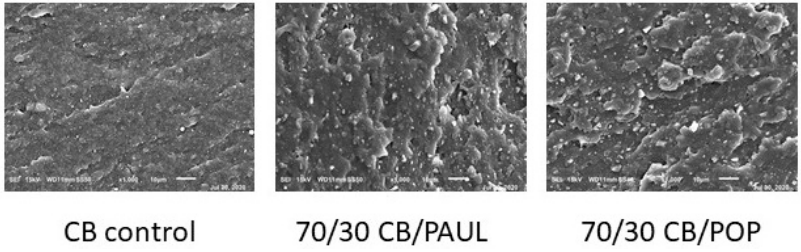
Figure 3. Stress-strain curves of the CB control (black line), 70 / 30 CB / silica milled PAUL (open circles), 70 / 30 CB / silica milled POP (open squares), 100% silica milled PAUL (open triangles), and 100% silica milled POP (open diamonds). Below the stress-strain curves SEM images at 1000 × of the 70 / 30 CB / biochar composites are shown next to the CB control for comparison. SEM images of the 100% silica milled PAUL and POP samples can be seen in Figure 2E,F, respectively.